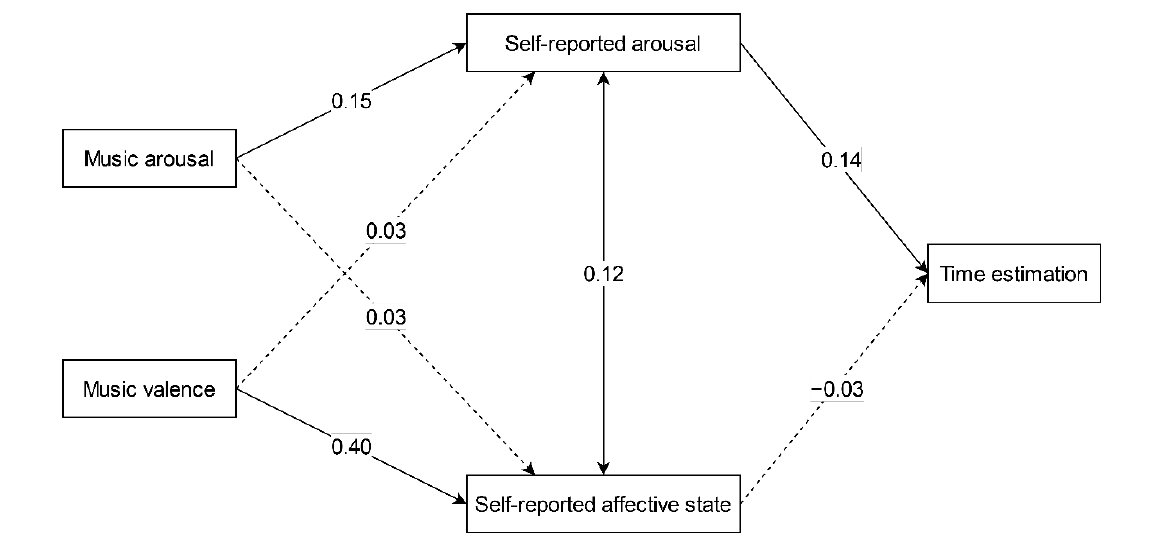
Figure 5. Time estimate (delta) as a function of the soundtrack. Note . Results of path analysis: χ 2 test of model fit = 3.77 ( p = 0.151) Comparative Fit Index (CFI) = 0.986. Absolute fit indexes: Root Mean Square Error of Ap- proximation (RMSEA) = 0.040 (90% CI = 0.001–0.101); Standardized Root Mean square Residual (SRMR) = 0.018. Parameters estimates are standardized. Dotted lines represent the insignificant relationships. Continuous lines represent paths with p <